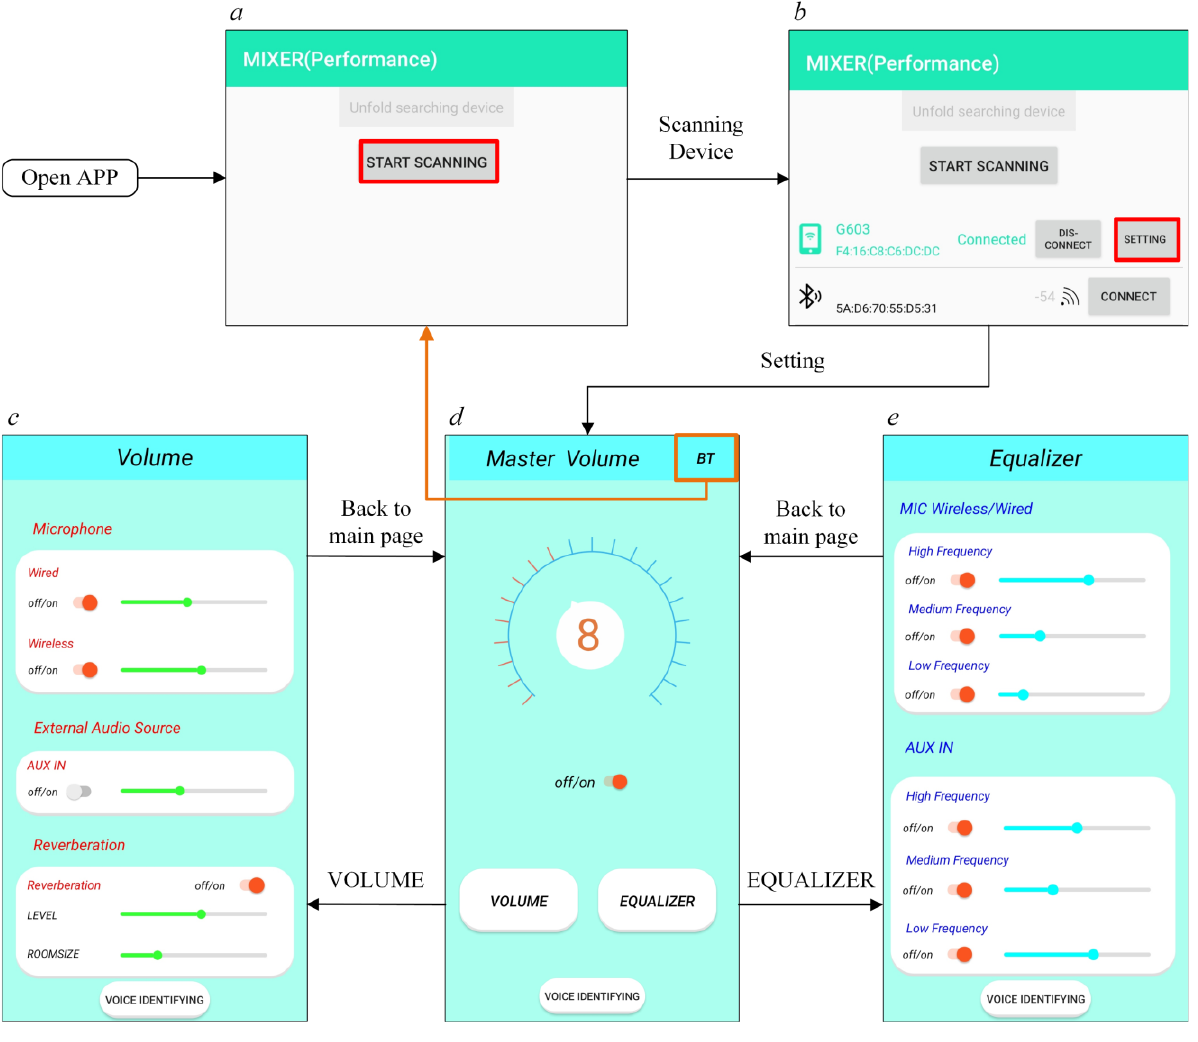
Figure 8. Flowchart of the APP operation.